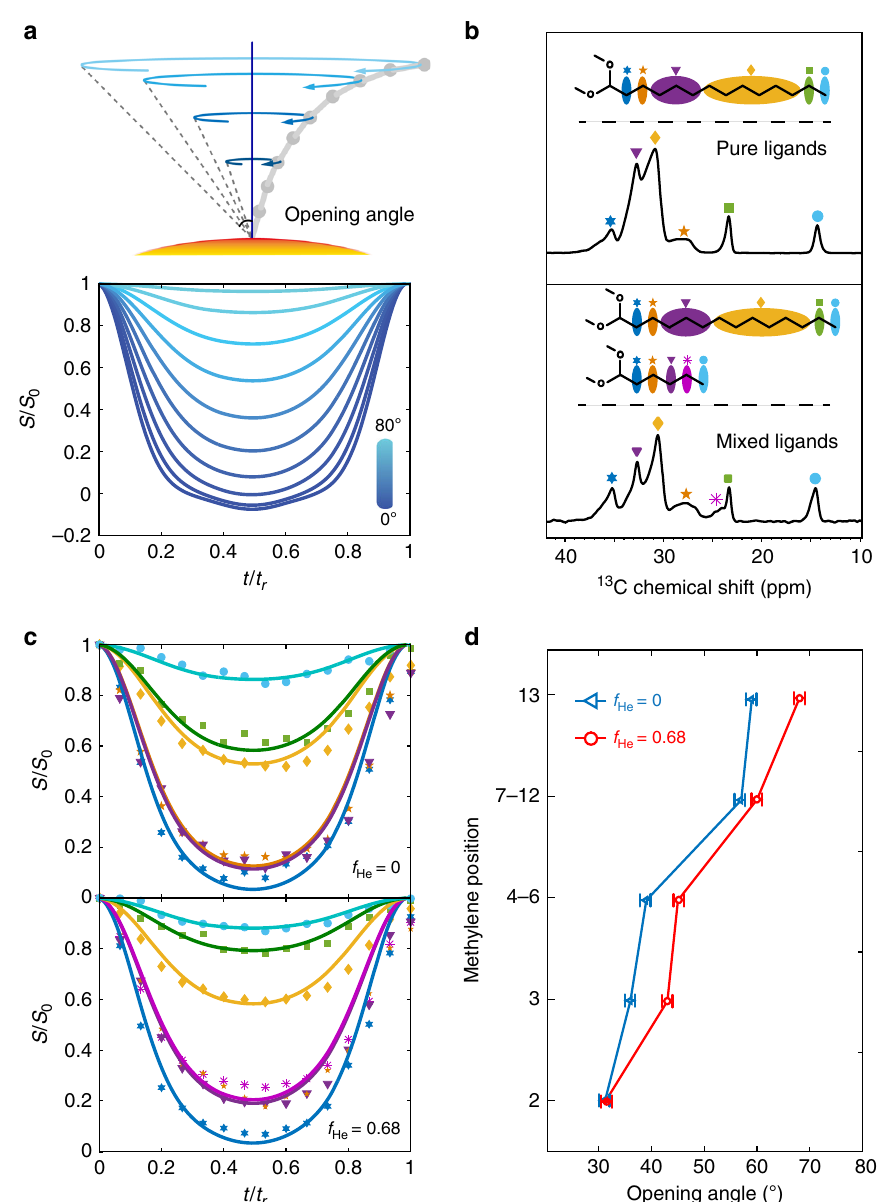
Fig. 4 1 H- 13 C DIPSHIFT results and opening angles. a The cone diffusion model of methylenes and the simulated DIPSHIFT curves for different opening angles. b 13 C solid-state NMR spectra obtain at 300 K. The peaks correspond to the chain segments labelled by the same symbols. c The DIPSHIFT results (dots) and fi tting curves (solid lines). The colors correspond to the chain segments labelled in ( b ). d The opening angles of each chain segment of myristate ligands assuming the cone diffusion motion. The fi tting standard deviation is smaller than one degree. The methylene positions are de fi ned in Fig.